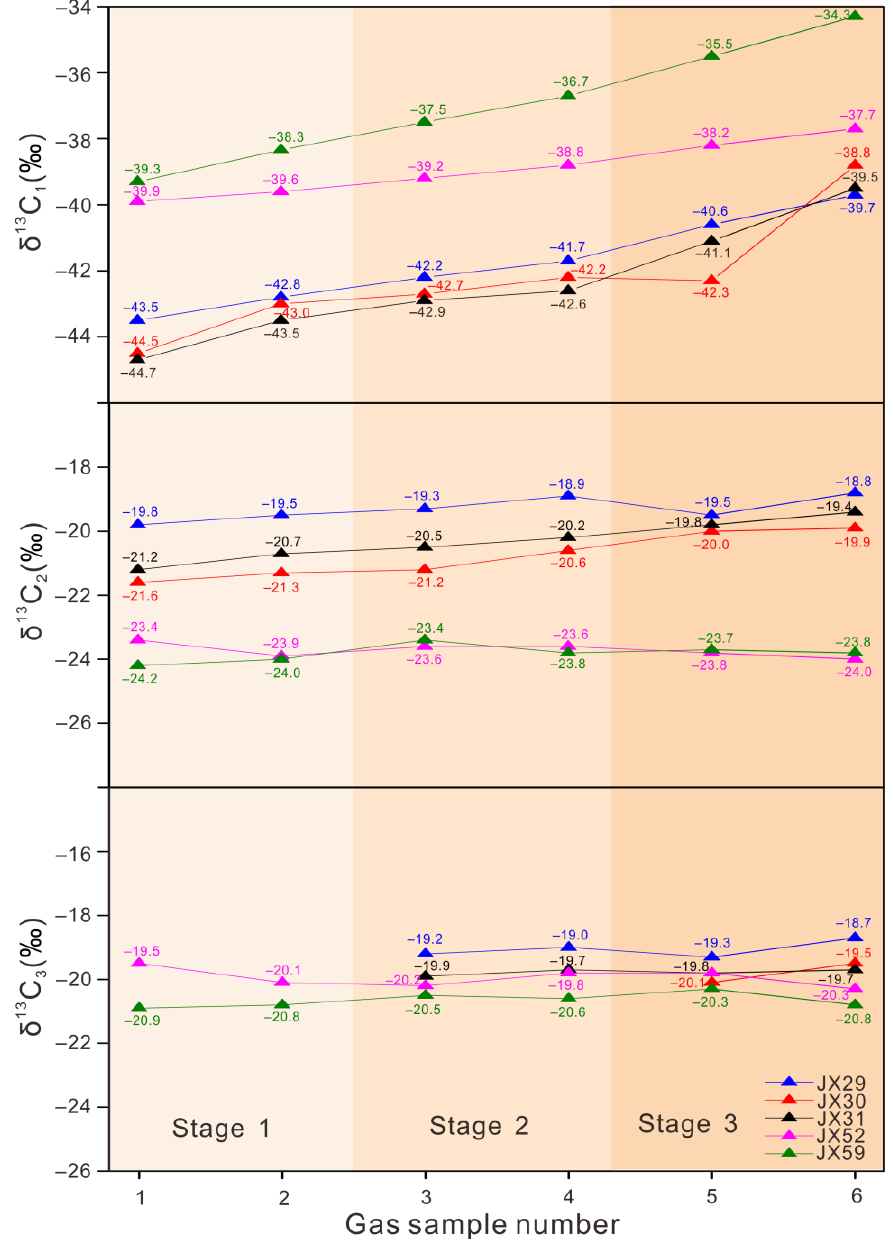
Figure 6. Carbon isotope variation of methane, ethane, and propane during degassing of five shale core samples from well ZY-1 (points 1 and 2 represent gas released at stage 1; points 3 and 4 represent gas released at stage 2; points 5 and 6 represent gas released at stage 3).